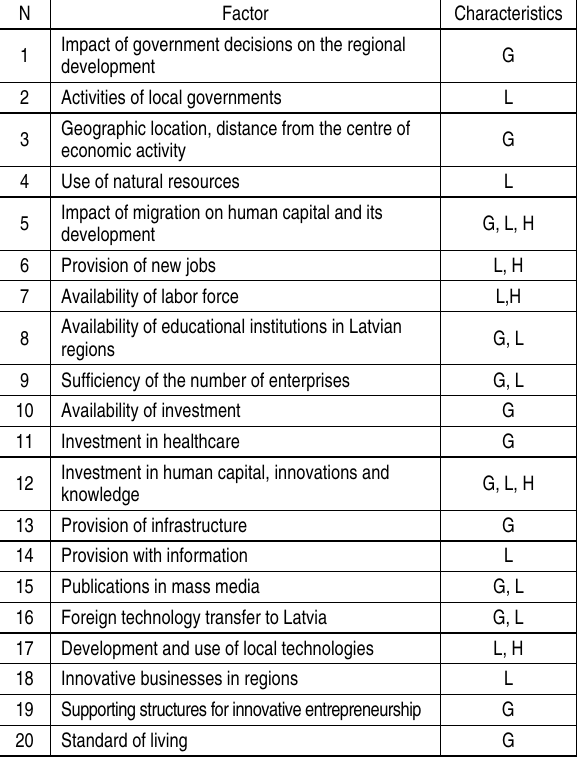
Fig. 4. Non-financial investments in Latvian regions, 2000-2014 Source: Central Statistical Bureau of Latvia. Table 1. Factor impact